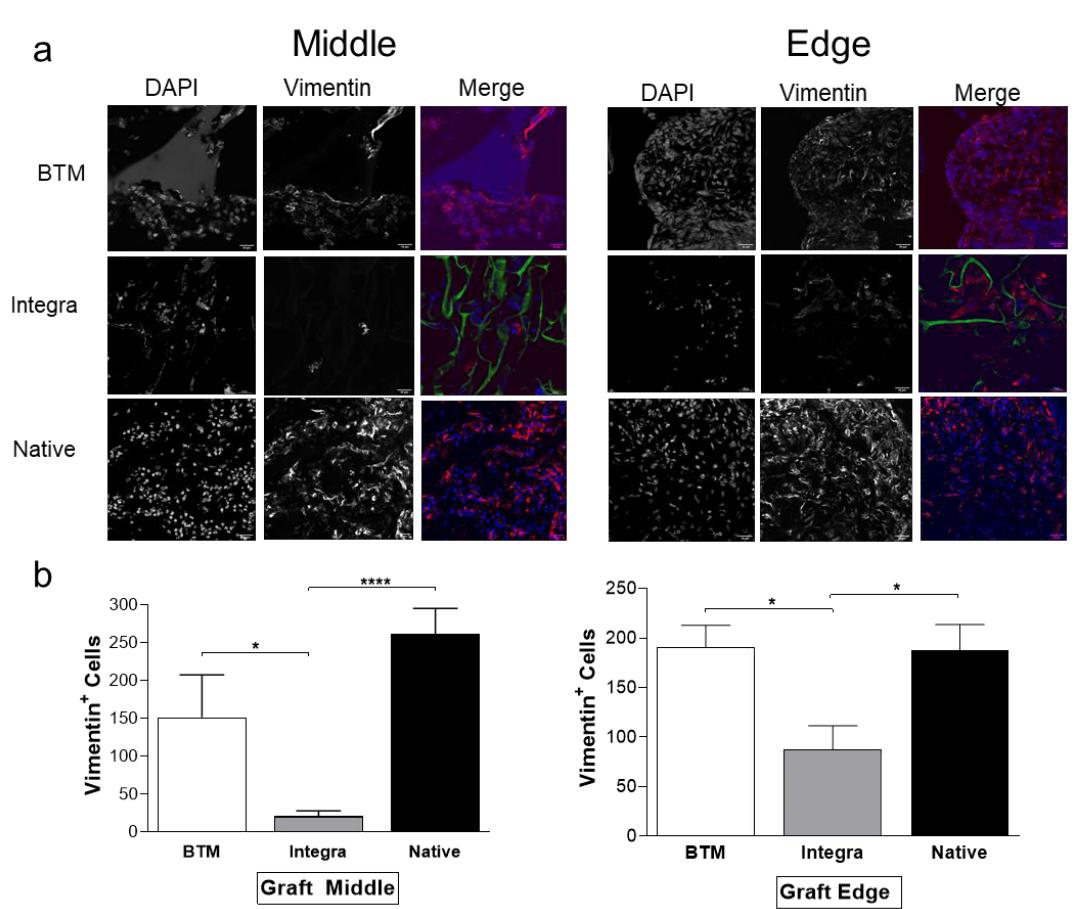
Figure 2 . Mesenchymal host infiltration in mouse grafts. ( a ) Fibroblasts were detected by confocal microscopy using a vimentin antibody (in red) and DAPI (in blue). Dermal template autofluorescence is shown in green (scale bar 50 µm). ( b ) Vimentin positive cells were quantified on NIS Analysis software (Nikon, Japan) in six fields of view ( n = 4–6 mice per group). Values represent mean +/− SEM